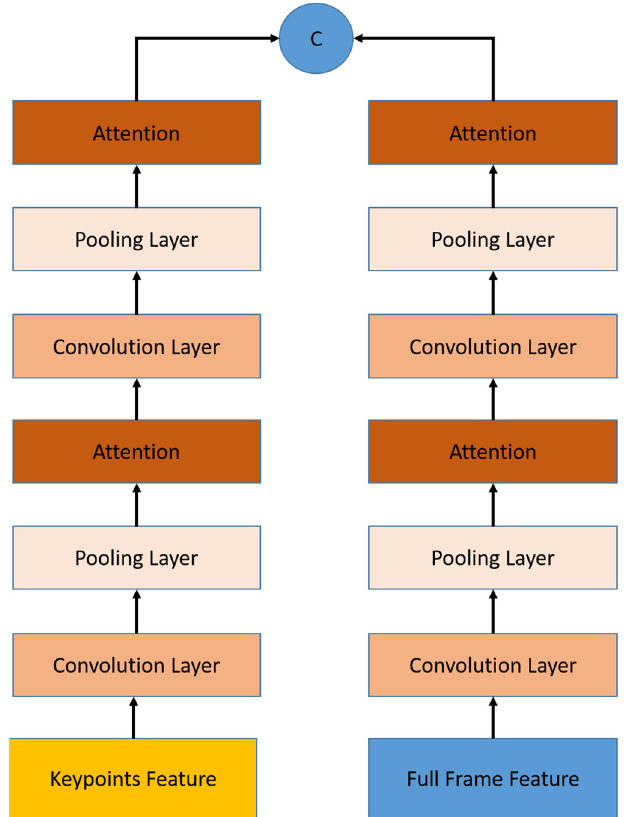
Figure 5. Temporal module architecture consists of a stacked 1D-CNN and pooling layer embedded with attention module. Work in parallel for both feature streams, concatenated at the end of the stacked layers, and produce a single temporal feature with a sequence length four times smaller.